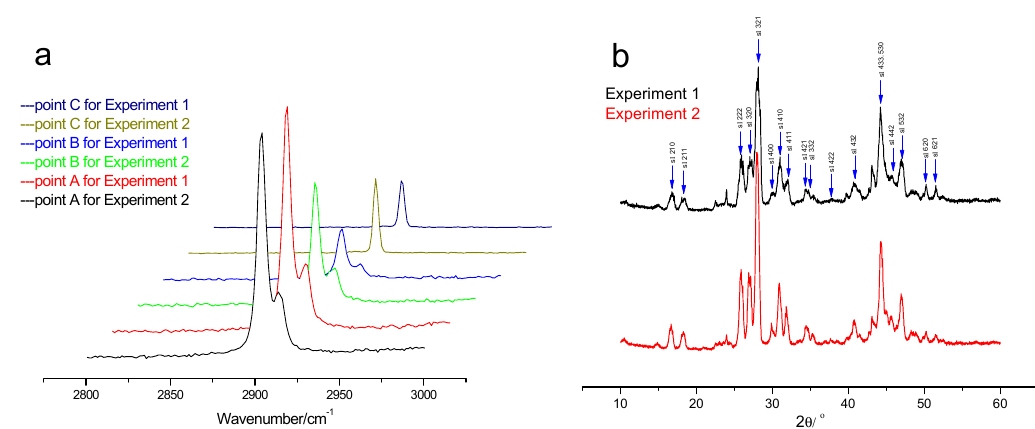
Figure 2. The Raman spectra for point “A”, “B” and “C” ( a ) and powder XRD pattern for experiment 1 and 2 ( b ).